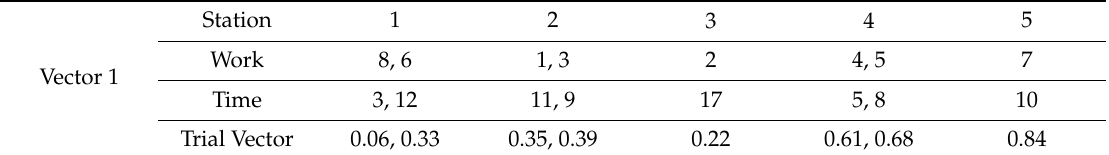
Table 4. The results of UALB by using the Trial Vector from Table 3.